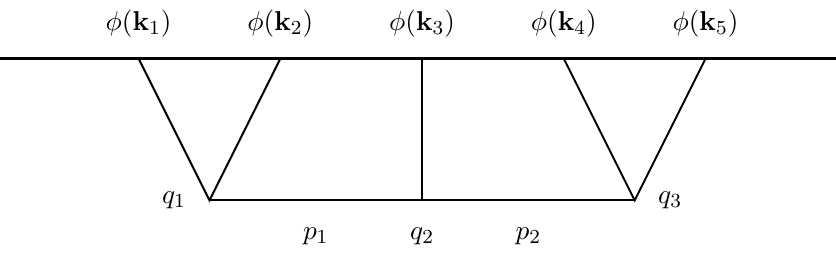
Figure 8 . The scalar quintic wavefunction ψ s